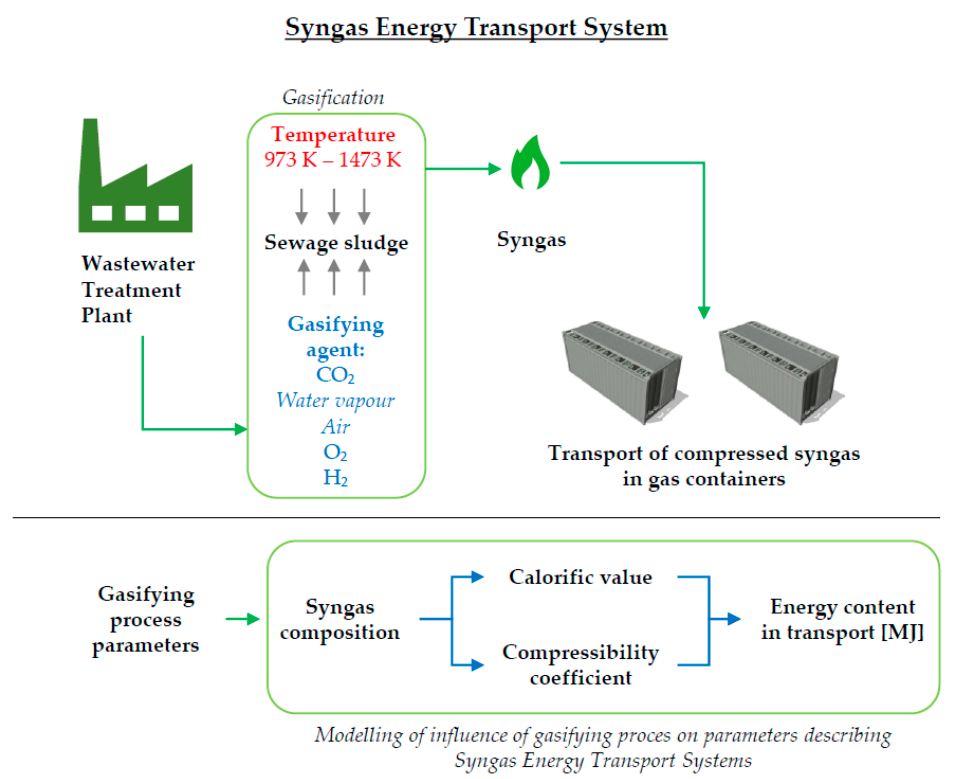
Figure 1. Optimization of sewage sludge gasification is part of a proposed syngas energy transport system (SETS) concept. The SETS is based on the waste-to-energy gasification of sewage sludge, compression of syngas, resulting in increased flexibility of storage, delivery and end-use options based on the standard ISO 20 feet containers equipped with smaller compressed gas tanks.